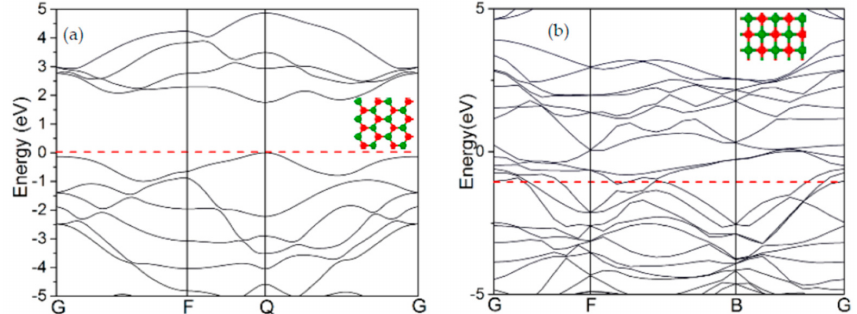
Figure 8. The band structures of ( a ) the initial hexagonal SLMoS2 nanosheets (semiconducting) and ( b ) the new phase of the quadrilateral structure